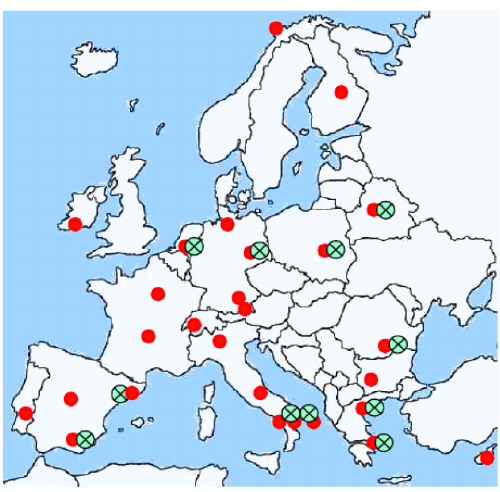
Figure 13. Map of the EARLINET stations (red dots). Green dots indicate the stations where LIRIC program package has been im-